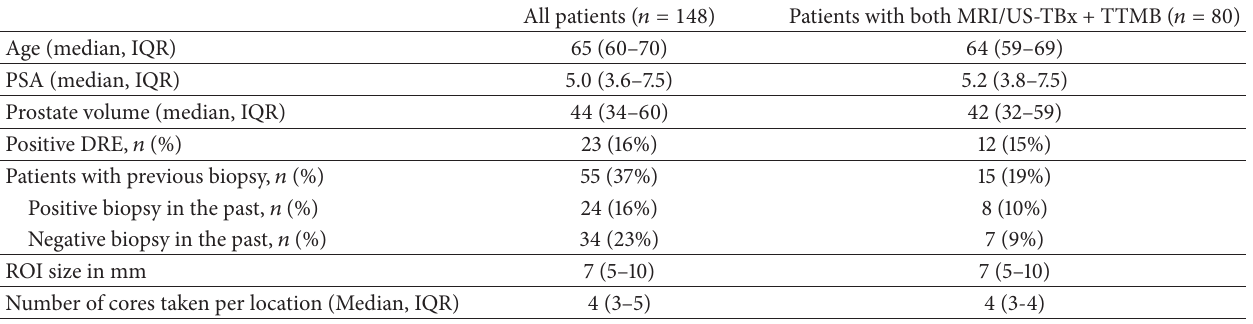
Table 1: Baseline characteristics of MRI/US fusion targeted biopsy cohort.